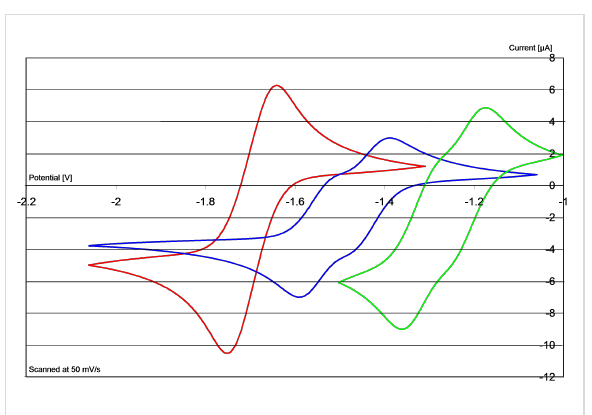
Figure 3: Cyclic voltammograms in DMF of 8/4 (red), 6/1 (green) and 22/9 (blue). Current plotted vs V relative to Fc/Fc + .